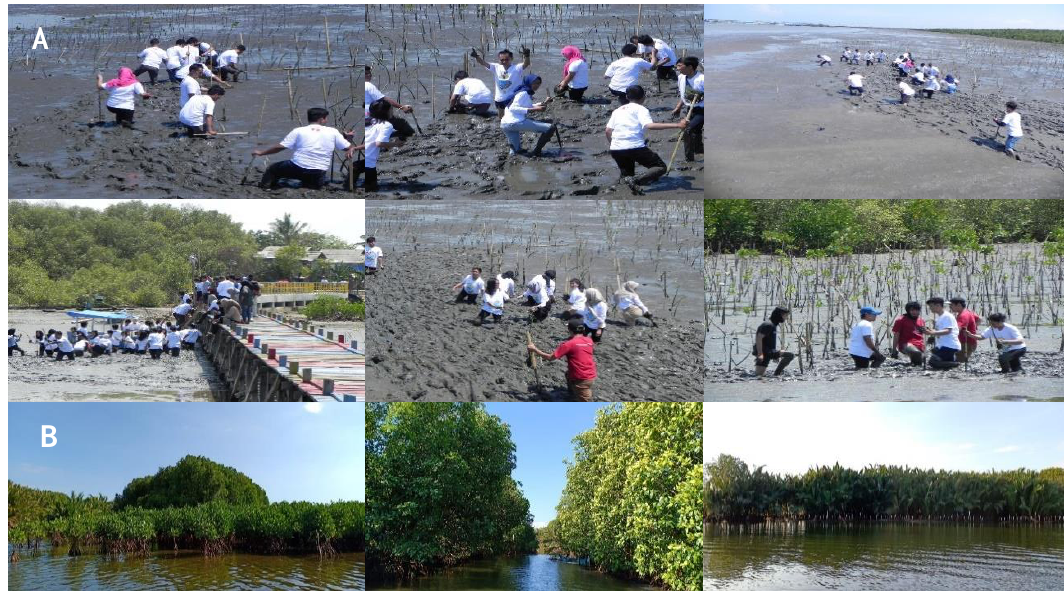
Figure 8. ( A , B ), Example, Rehabilitation of Mangrove Forests along the Tallo River Basin. Source: author elaboration, and Primary Data .